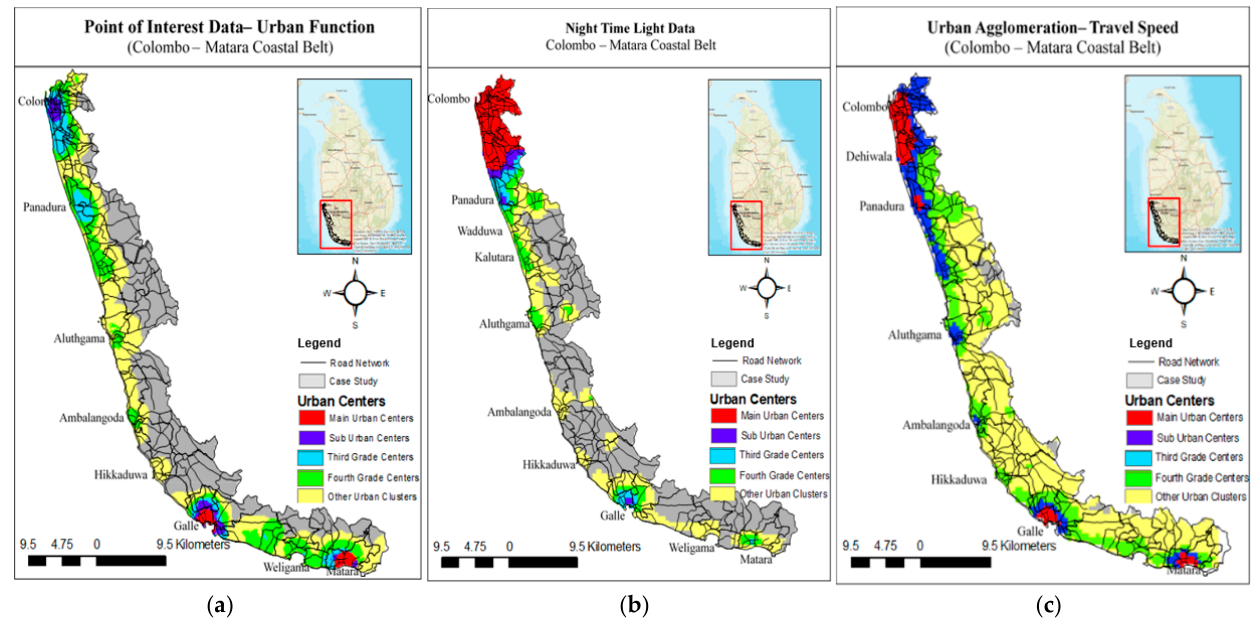
Figure 6. Urban function-related parameters of ( a ) PoI data; ( b ) NTL data; ( c ) Travel speed.